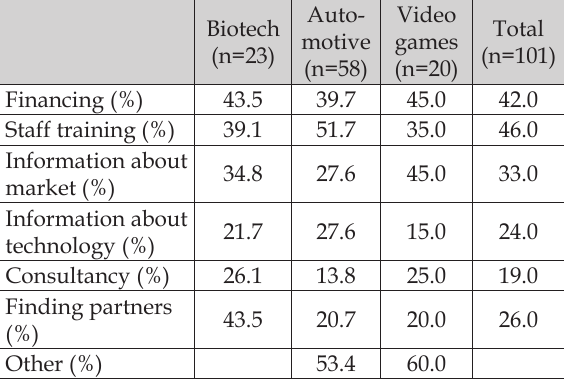
Table 5. Policy support demanded by firms in differ - ent industries.